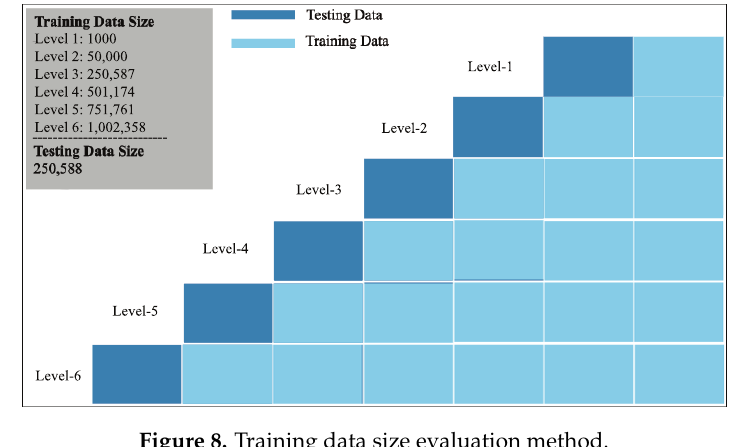
Figure 8. Training data size evaluation method.